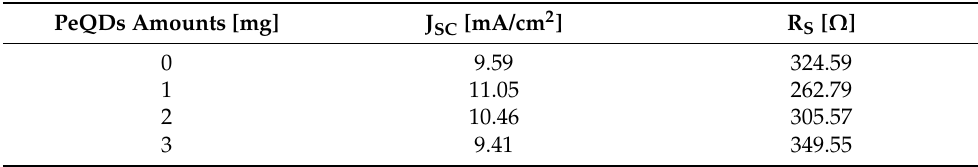
Table 1. The evaluated parameters (J SC and R S ) of the proposed